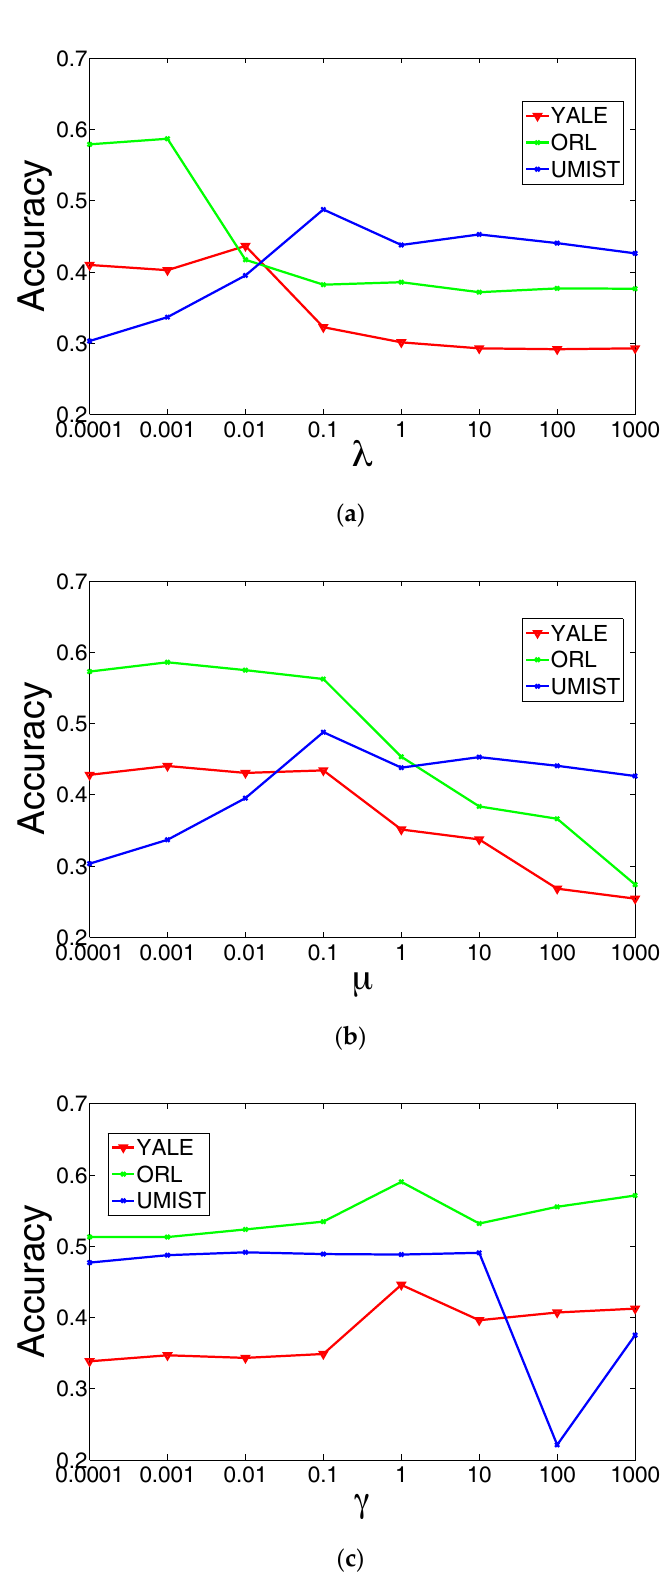
 HNMFD in 3 datasets: 21 